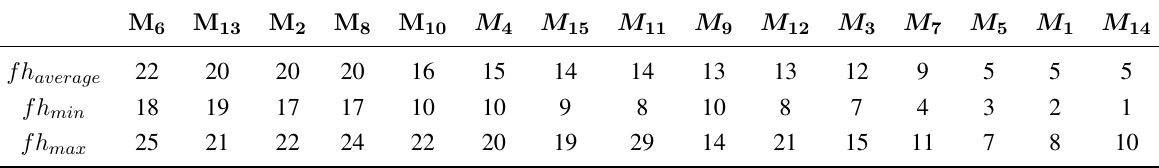
model from Patient A. Future horizons for fit at 70% i